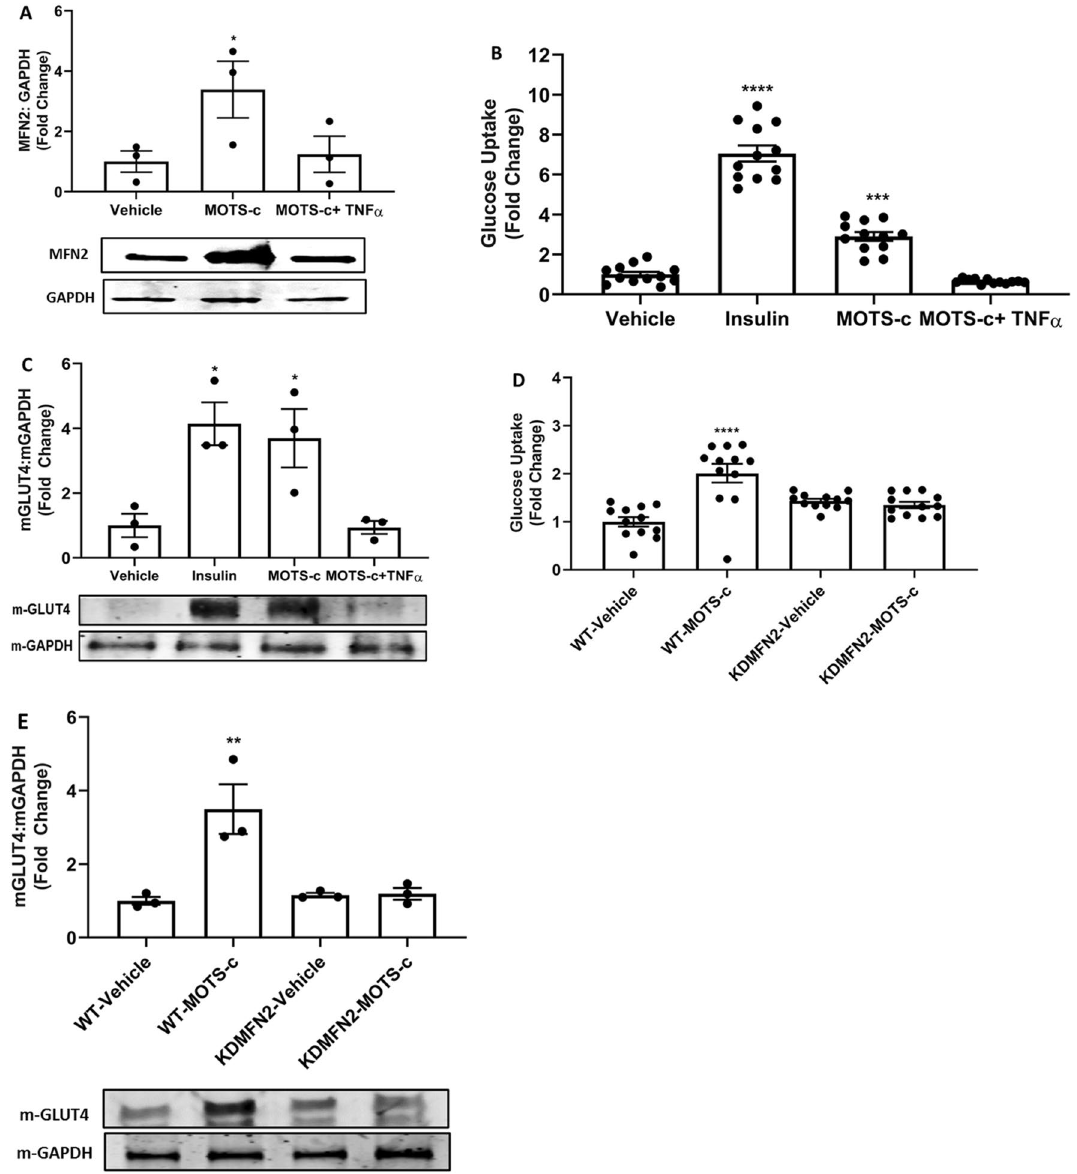
Figure 7. Mitofusion underlines the ability of mitochondrial peptide MOTS ‐ c to prompt GLUT4 translocation. MOTS-c (100 μM) treatment prompted ( A ) MFN2 increase in D12 adipocytes ( B ) MFN2 dependent glucose uptake and ( C ) MFN2 dependent membrane GLUT4 translocation in D12 adipocytes was abrogated by TNFα (10 ng/mL), a known inhibitor of mitofusion, and in ( D , E ) siRNA KD of MFN2. D12 pre-adipocytes were differentiated into brown adipocytes in DMEM/F12 media supplemented with 15% fetal bovine serum (FBS), 1% l-Alanyl-l-Glutamine plus 1% pen-strep to detect glucose uptake (Glucose Uptake-Glo™ Assay) and western blot was performed to quantify the protein expression level of GLUT4. GAPDH was used as the internal control for western blot. Data are means ± SEM of three to twelve experiments. All full-length blots are presented in Supplementary Figure WB1. Statistical analysis was conducted using ordinary one-way ANOVA followed by Dunnett’s multiple comparisons test vs vehicle; results are presented as *p < 0.05, **p < 0.01 and ****p < 0.0001 vs.